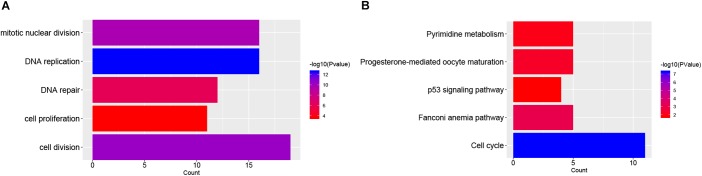
Functional enrichment analysis of DEGs in NB. (A) The top 5 gene count of gene ontology (GO) terms in NB-related genes; (B) The top 5 significant KEGG pathways in NB-related genes.